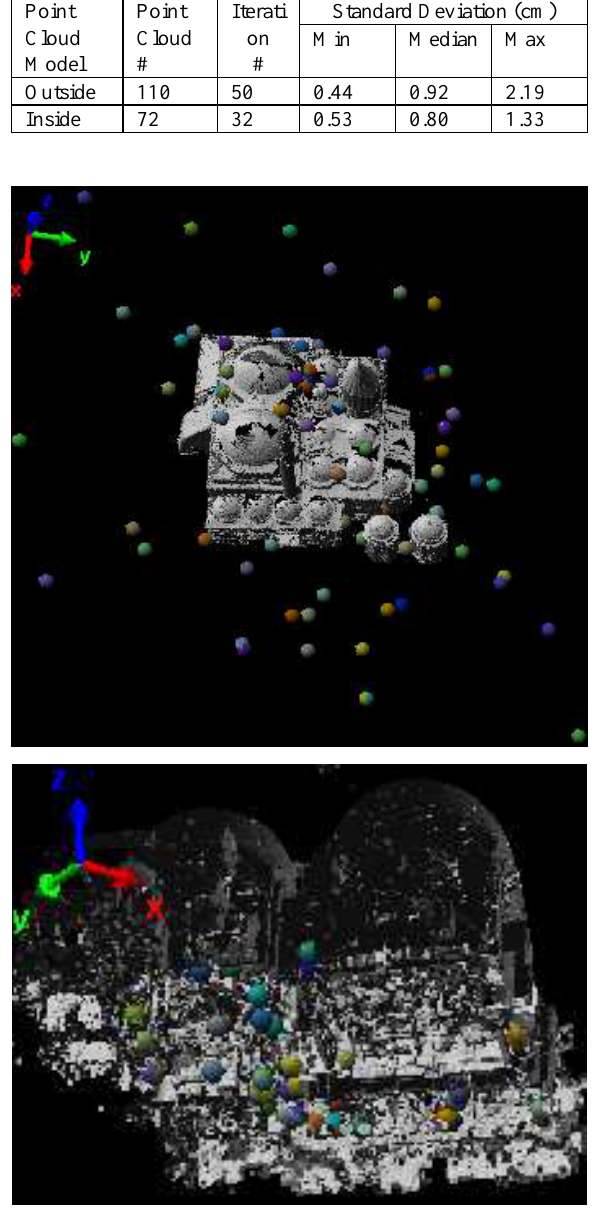
Figure 4. The laser scanning stations of outside (above) and inside (below) measurement of the Mevlana Museum.